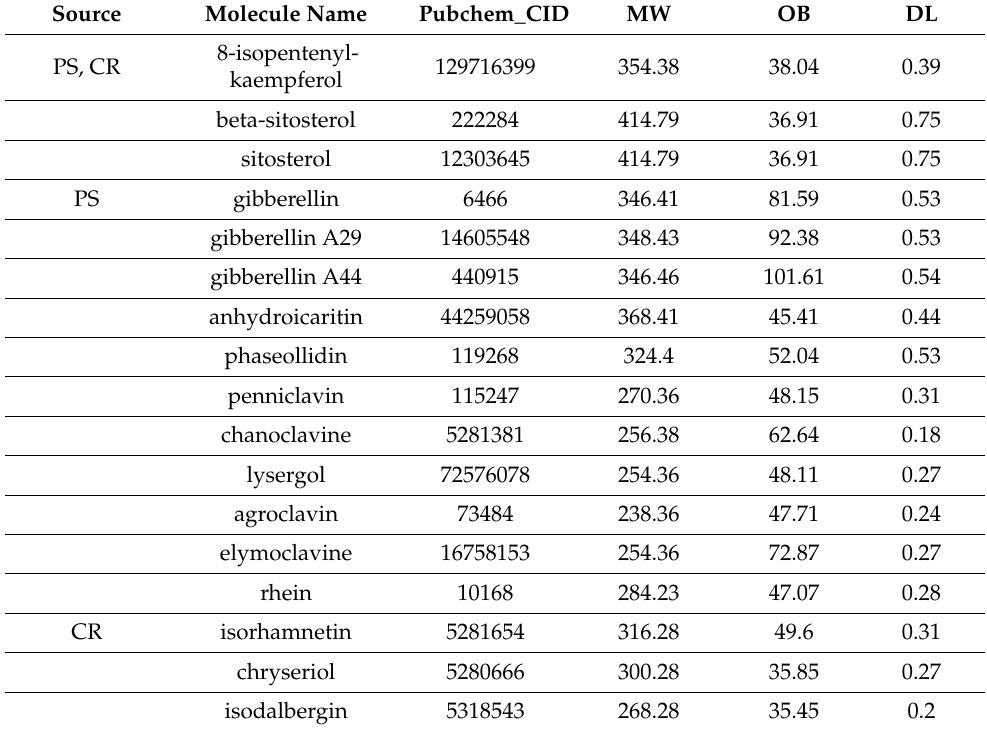
Table 1. List of potent active compounds from three herbs. PS— Pharbitis Semen, TF— Trogopterorum Faeces , and CR— Cyperi Rhizoma